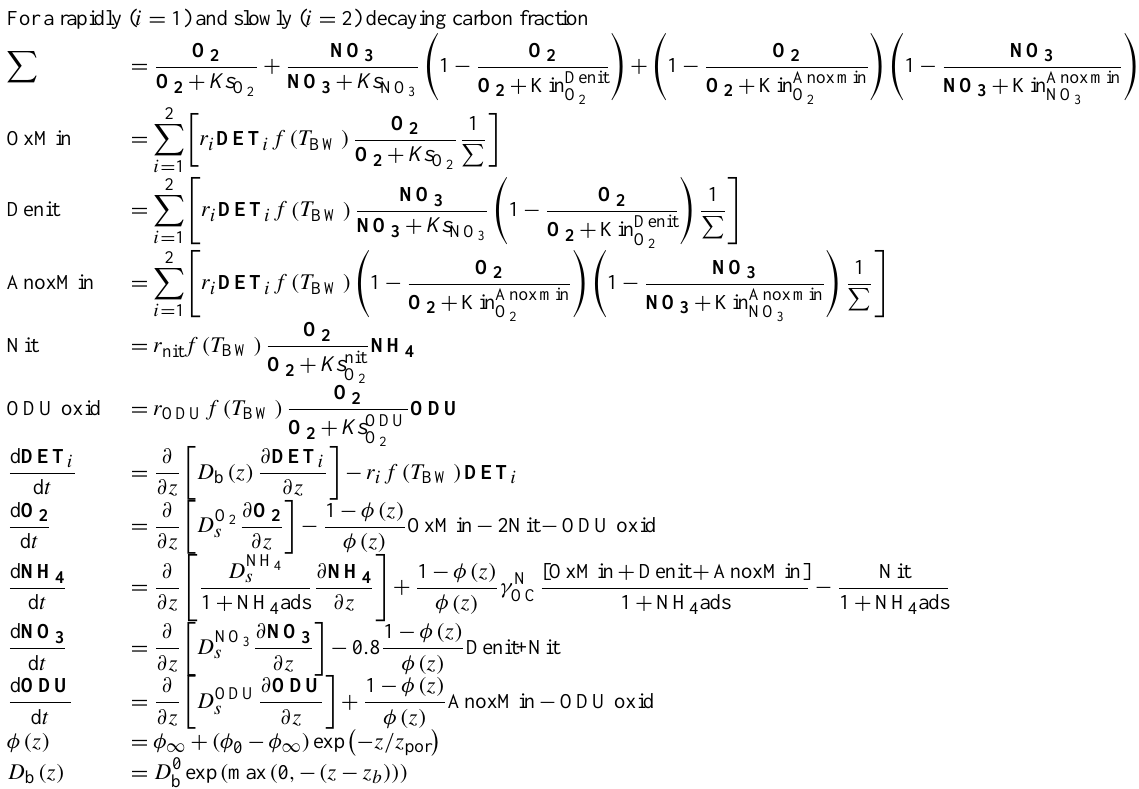
Table 7. Model equations incorporated in the benthic biogeochemical model. State variables are in bold. The quantity z represents the depth into the sediment. Bottom water temperature ( T BW ), Oxic mineralisation (OxMin), anoxic mineralization (AnoxMin), nitrification (Nit), denitrification (Denit), oxidation of oxygen demand units (ODU